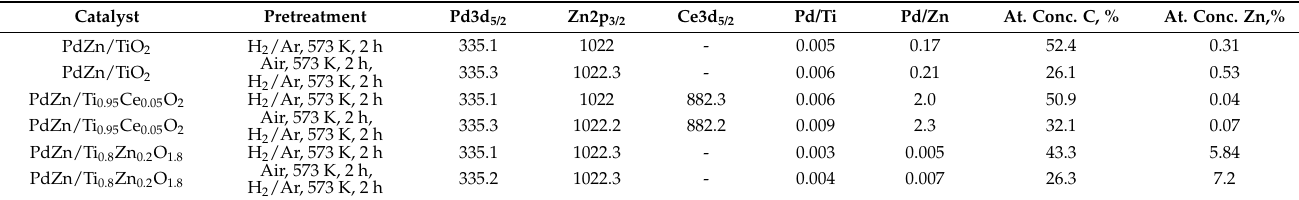
Figure 6. Peak fitting of Pd3d5/2 core-level spectra of ( A ) PdZn/TiO 2 , ( B ) PdZn/Ti 0.95 Ce 0.05 O 2 and ( C ) PdZn/Ti 0.8 Zn 0.2 O 1.8 after reduction with 30 vol.% hydrogen in argon at 573 K for 2 h.